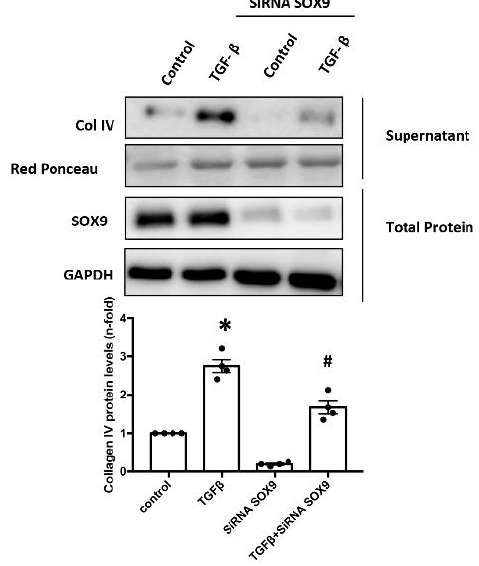
Figure 7. SOX9 gene silencing by specific siRNA decreases Type IV collagen protein levels in human mesangial cells. SOX9-silenced cells were stimulated with 10 ng/mL TGF- β1 for 48 h. COLIV protein levels were evaluated by Western blot in the supernatant of mesangial cells. Sox9 protein levels were evaluated by Western blot to corroborate a correct silencing protocol. Data are expressed as mean ± SEM of 3 independent experiments. * p < 0.05 vs. control # p < 0.05 vs. treated cells with TGF- β1 .